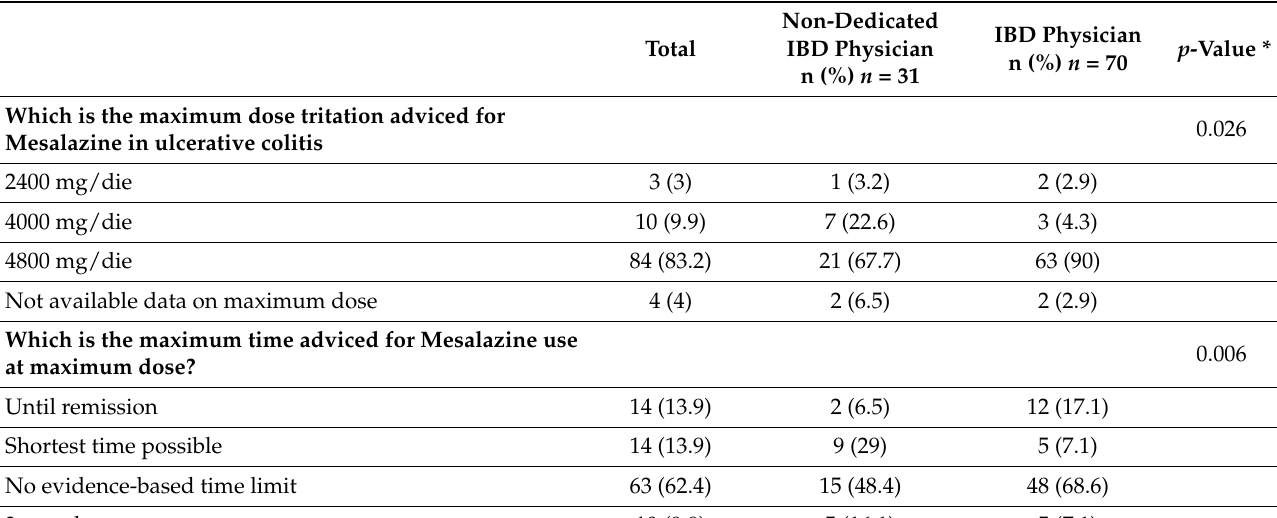
Table 3. Administration, safety, adherence, and prevention in inflammatory bowel